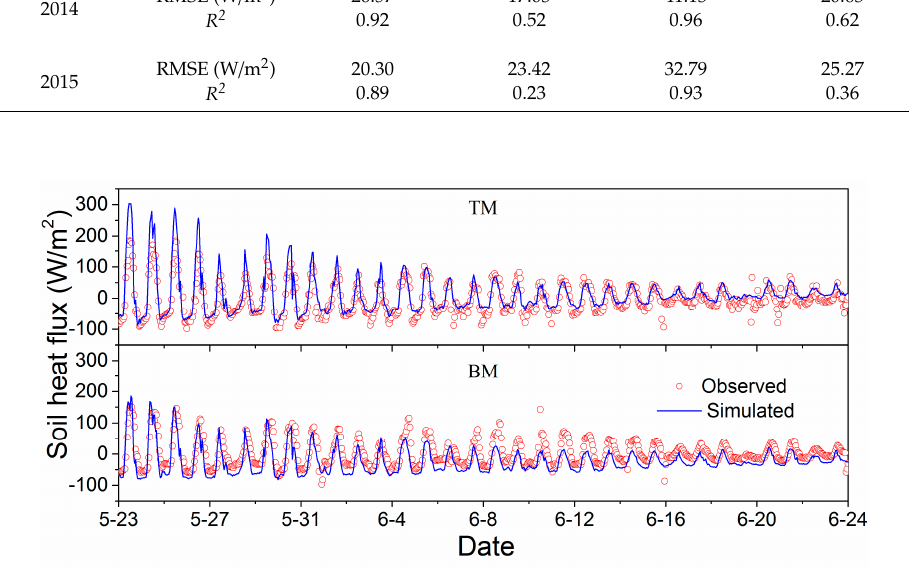
Figure 10. Comparison of the observed and simulated hourly soil heat flux of the transparent plastic film mulch (TM) treatment and black plastic film mulch (BM) treatment at Wuwei, China, in 2015.